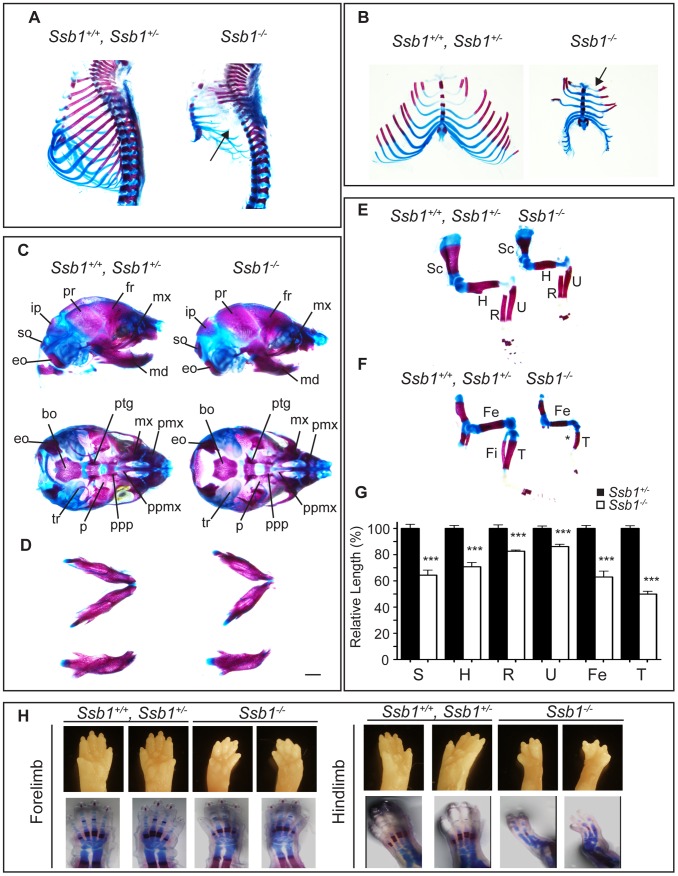

Ssb1 deletion causes multiple skeletal defects.(A) Alcian blue and Alizarin red staining of control (Ssb1
+/+, Ssb1
+/−) and Ssb1
−/− E18.5 ribcages. (B) Butterfly rib-spread of Ssb1 control and Ssb1
−/− E18.5 ribcages. (C) Comparison of skull anatomy of Ssb1 control and Ssb1
−/− E18.5 embryos. eo, exoccipital; so, supraoccipital; ip interparietal; pr, parietal; fr, frontal; mx, maxilla; md, mandible; bo, basioccipital; ptg, pterygoid; pmx, premaxilla; ppmx, palatal process maxilla; ppp, palatal process palatine; p, palatine; tr, tympanic ring. (D) Comparison of Ssb1 control and Ssb1
−/− mandibles (Scale = 1 mm). (E) Forelimb and (F) Hindlimb of E18.5 Ssb1 control and Ssb1
−/− embryos. Sc, scapula; H, humerus; R, radius; U, ulna; F, femur; T, tibia. * designates missing fibula. (G) Quantification of long bone measurements of the forelimb and hindlimb of Ssb1
+/− and Ssb1
−/− E18.5 limbs. Data represent the mean ± SEM of bone length (n = 3 per condition, ***P<0.001, student's t-test). (H) Whole-autopod (top) and skeletal preparation (bottom) of E18.5 forelimbs (left) and hindlimbs (right) from Ssb1 control and Ssb1
−/− embryos.